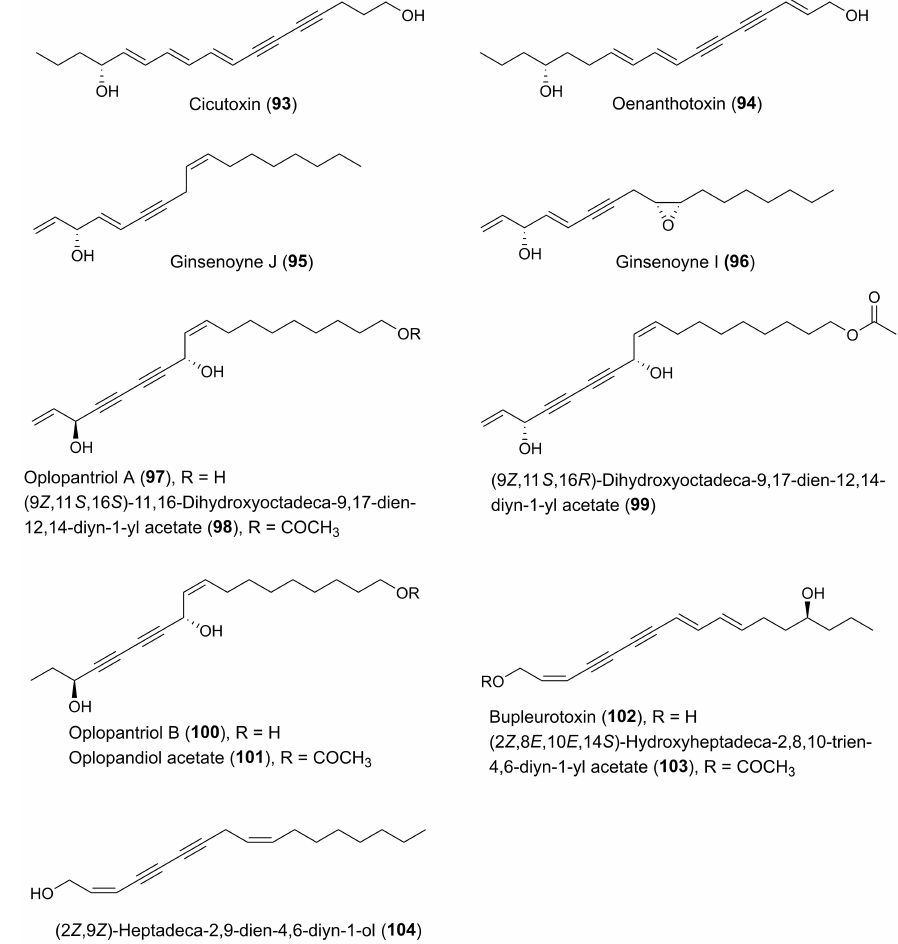
Figure 5. Miscellaneous cytotoxic C 17 and C 18 acetylenic oxylipins ( 93 – 104 ) isolated from medicinal plants belonging to the Araliaceae or Apiaceae